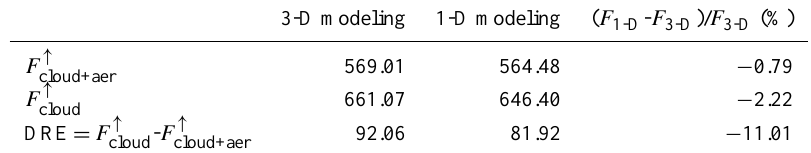
Table 2. Fluxes for polluted and clean conditions and DRE (Wm − 2 µm − 1 ) at the TOA at 0.490µm modeled using 3-D and 1-D